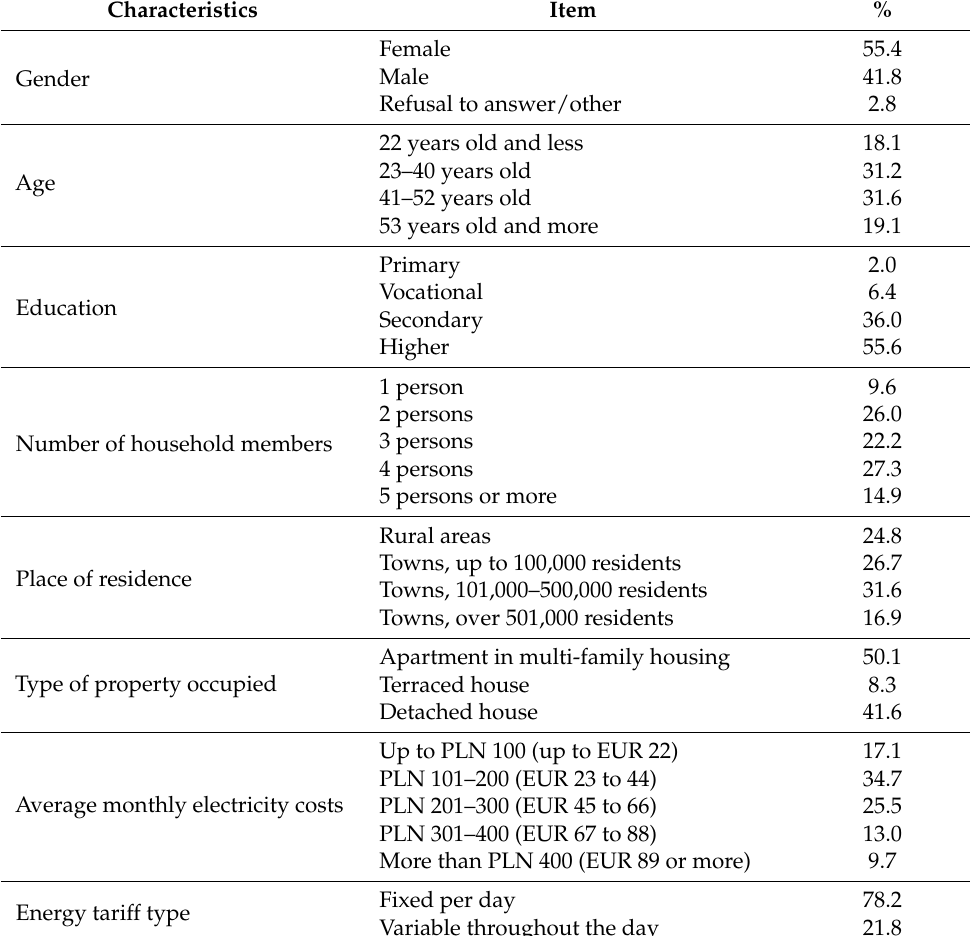
Table 2. Sample characteristics ( n = 1405, in